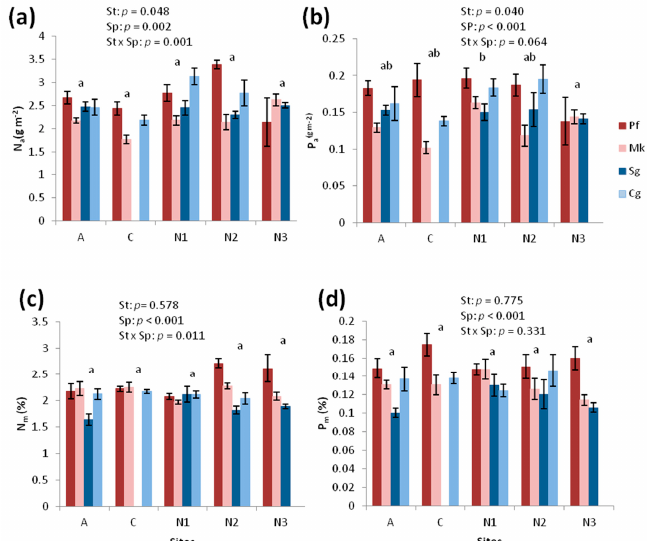
Figure 6. Leaf nitrogen per unit leaf area (N a ; ( a )), phosphorus per unit leaf area (P a ; ( b )), N per unit leaf mass (N m ; ( c )), and P per unit leaf mass (P m ; ( d )) in four species (Sp) at five sites (St) along an elevation gradient. Error bars represent standard error. Significant overall differences among sites are indicated by different letters above the bars of each site. Explanations of site abbreviations and species names are provided in Table 1 and Figure 1, respectively; the site order follows increasing elevation from left to right. The N:P ratio did not differ significantly among either sites ( p = 0.101) or species ( p = 0.794; Figure 7; Table S2). It ranged between 13–19 for all site by species combinations (Figure 7) and although site differences were not statistically significant, the average values were higher at the two highest sites (17.2 and 17.7) than at the other three sites (15.2–16.0; Table 1). The data thus clearly show that N limitation did not increase with elevation in our forests.